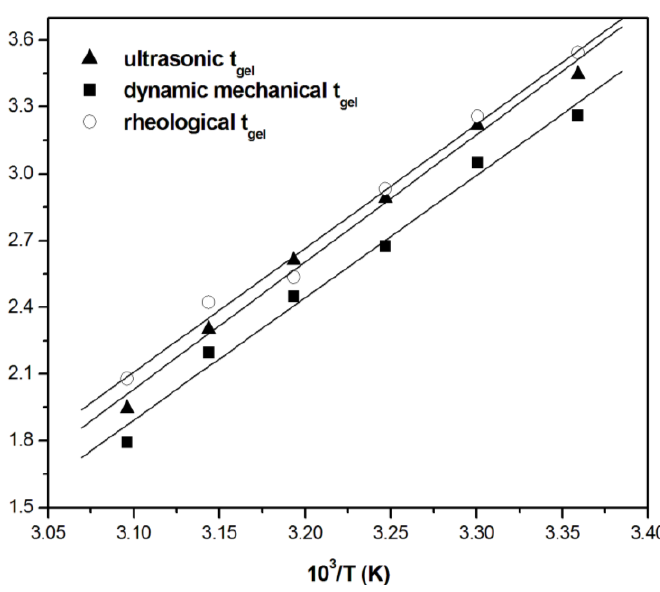
Figure 5. Arrhenius plot of the gel times calculated by different techniques versus the reciprocal of the isothermal cure temperature. Reprinted with permission from